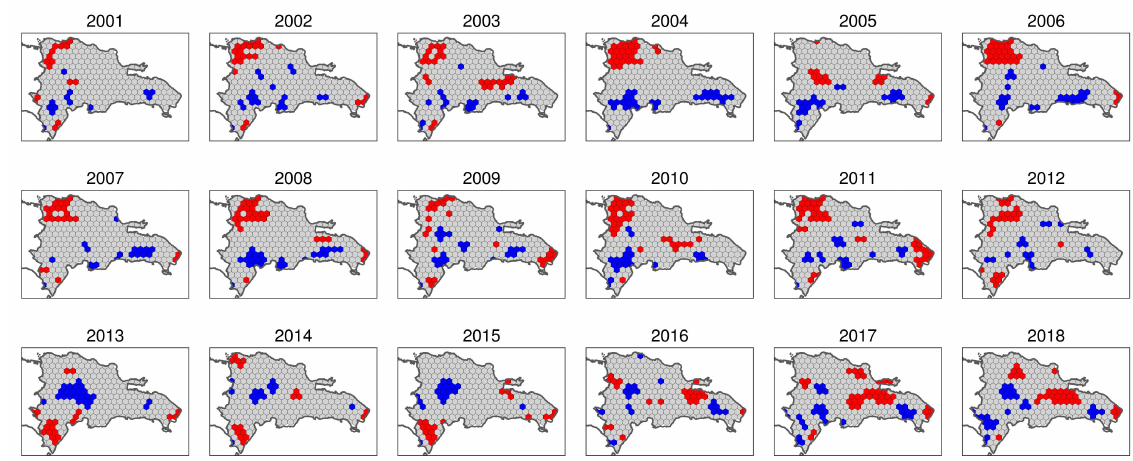
Figure 9 – Yearly LISA maps (local indicators of spatial association maps) of transformed forest loss density data of large clearings. Red represents HH clusters, blue depicts LL clusters, and grey shows no significant spatial association.